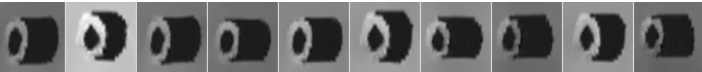
Figure 6. Examples of images by the pre-trained